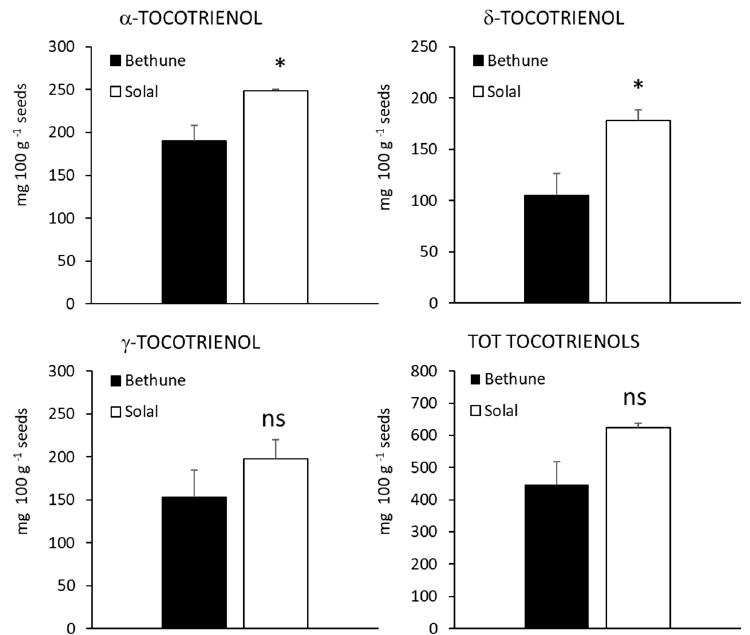
Figure 4. Concentration (mg 100 g − 1 seeds) of α -, δ -, γ - and total tocopherols of the two linseed varieties (Bethune and Solal). n.s. = not significant.